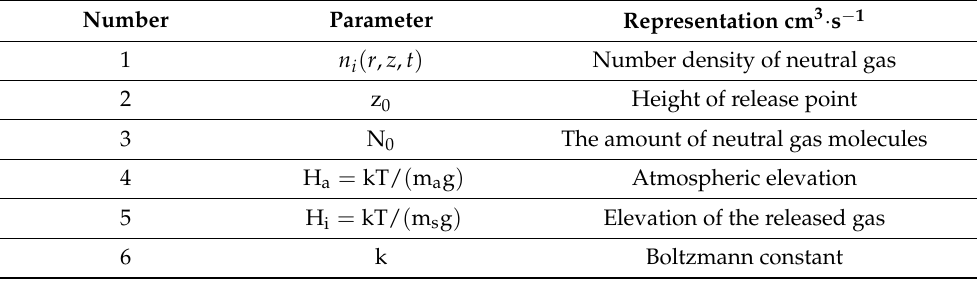
Table 2. The meaning of related parameters in the above Formula